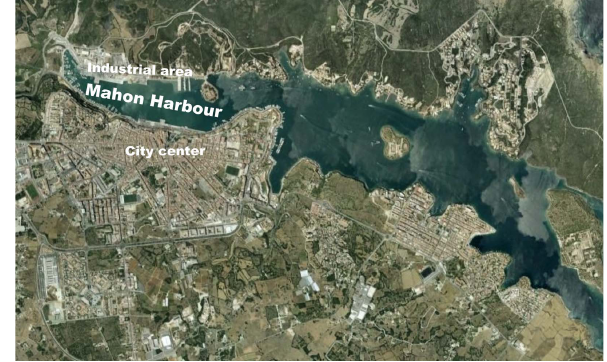
Fig. 10. Photograph of Benidorm, in Alicante; an important tourism centre of the Mediterranean Spanish coast. (Photograph of public domain from Wikimedia Commons).